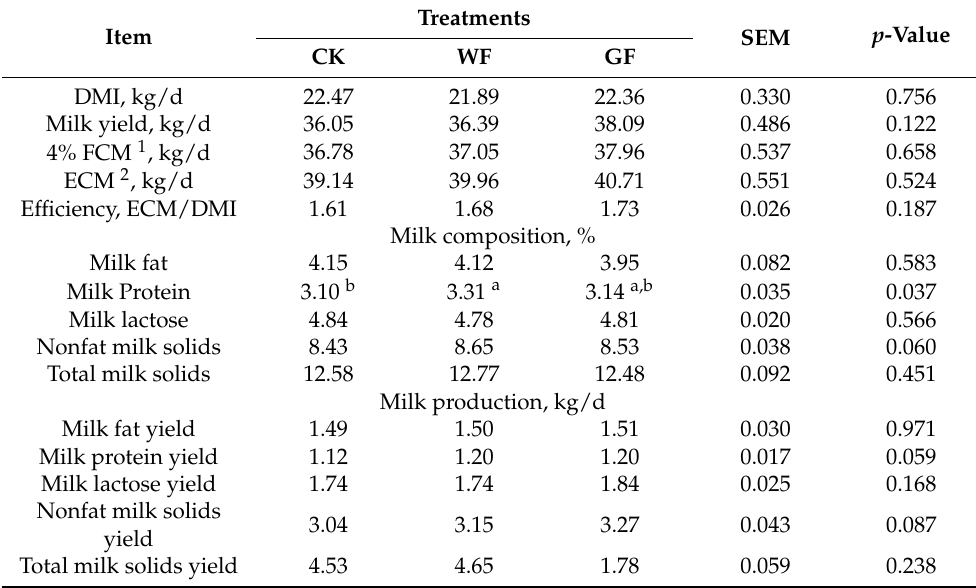
Table 2. Dry matter intake, milk composition, and milk yield of different treatment